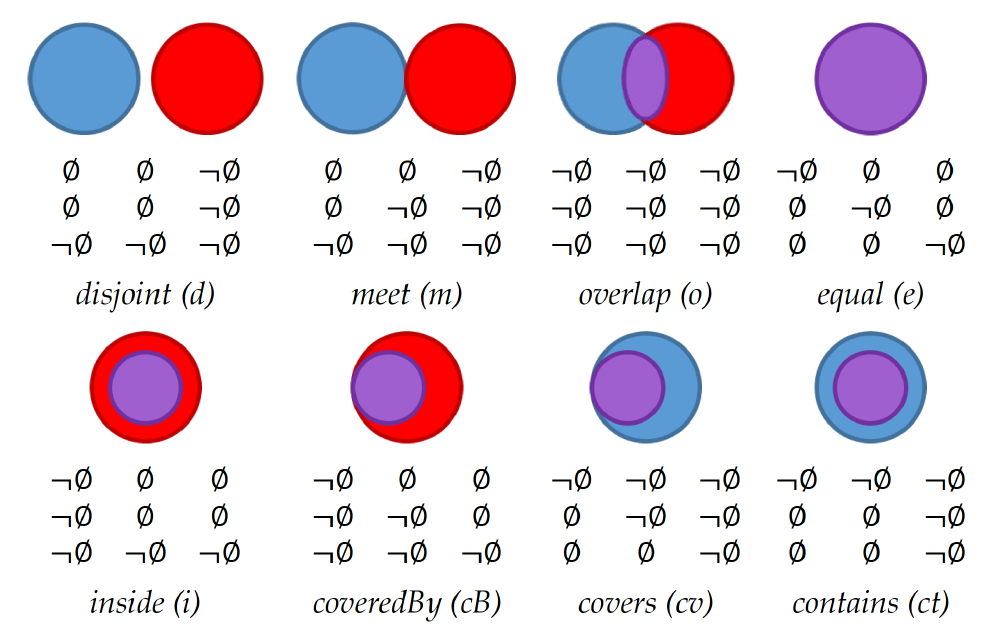
Figure 1: The eight simple region-region relations identified by the 9-intersection [17].